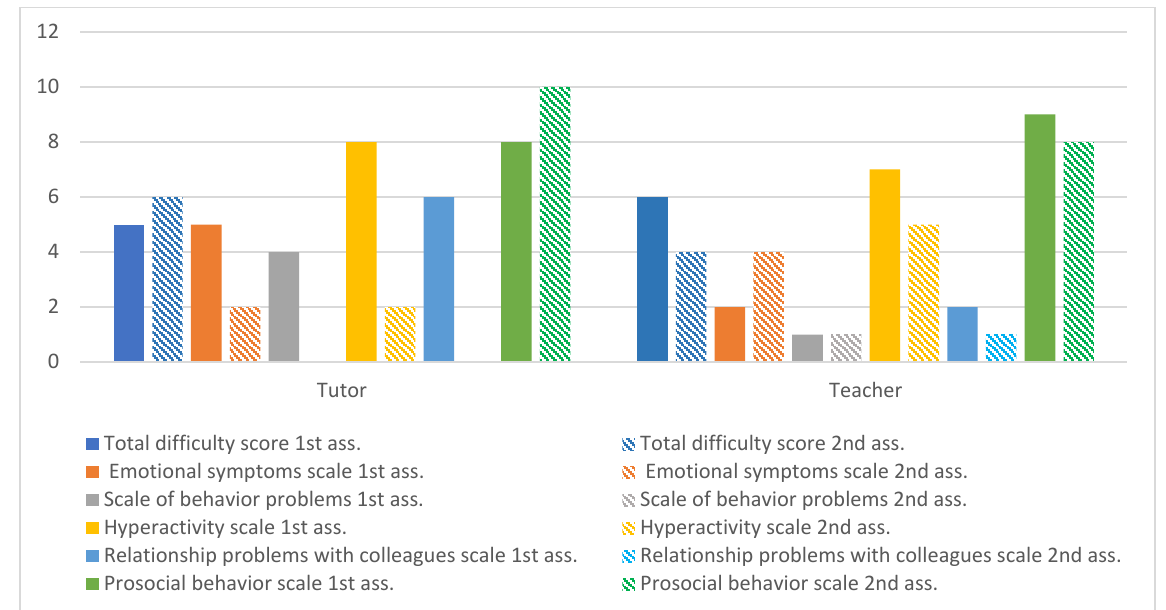
Total difficulty score 1st ass. Total difficulty score 2nd ass. Emotional symptoms scale 1st ass. Emotional symptoms scale 2nd ass. Scale of behavior problems 1st ass. Scale of behavior problems 2nd ass.